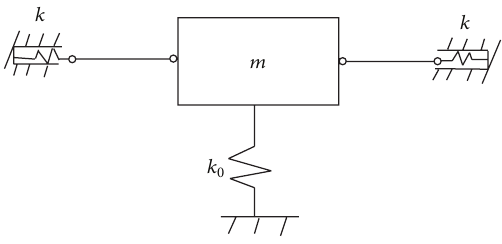
Figure 2: Positive and negative stiffness parallel